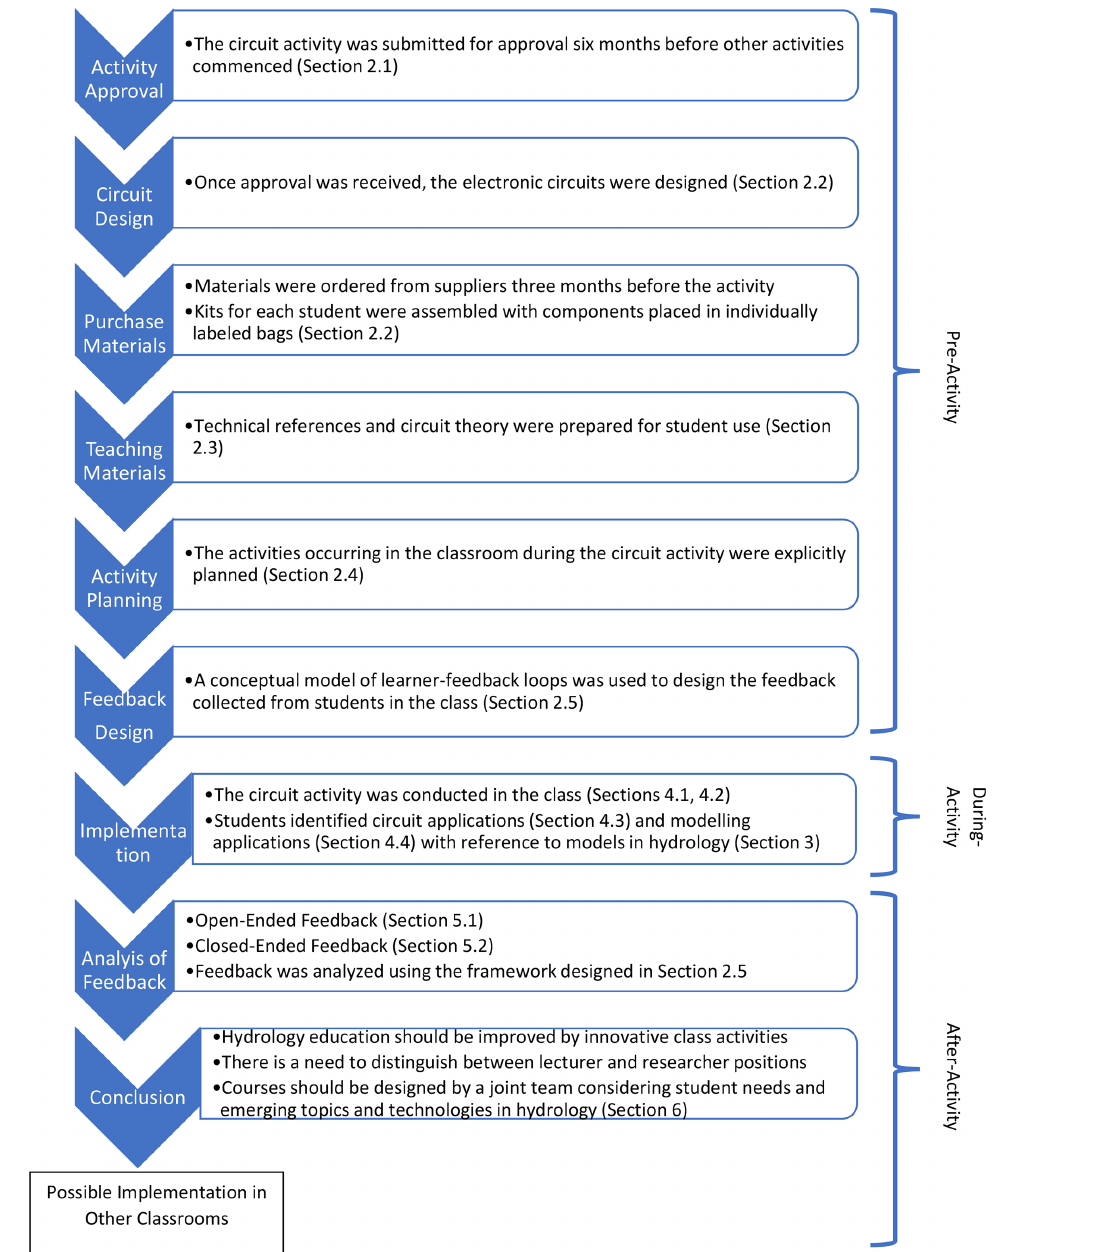
Figure 1. Workflow diagram showing stages of the class activity. A temporal classification of stages according to pre-activity, during-activity and post-activity tasks is shown along with a brief description of each